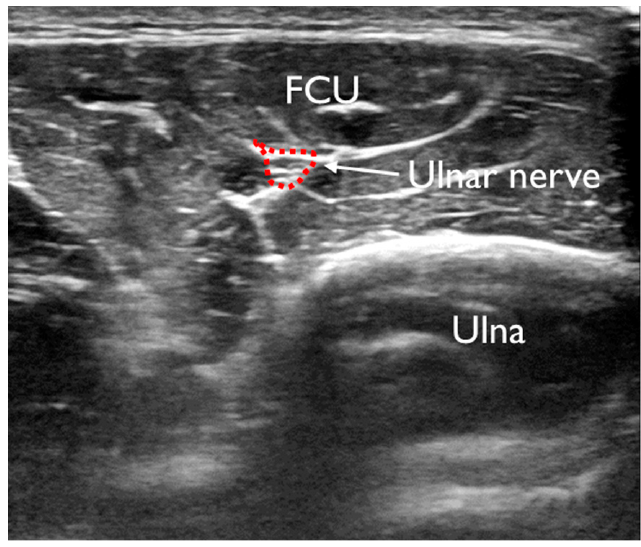
Figure 4. US image of ulnar nerve2.5. Statistics.